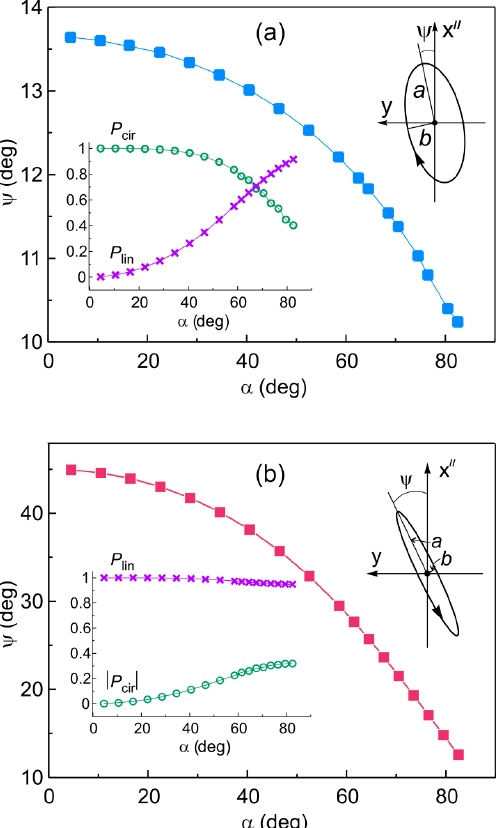
Figure 6. The angle ψ of the semi-major axis a of the refracted beam polarization ellipse relative to the plane of incidence σ , as well as the degrees of circular P cir and linear P lin polarizations of the refracted beam (insets) as a function of the angle of incidence α for ( a ) circularly and ( b ) linearly polarized ( Φ = − 45 ° ) radiation incident on a thin CuSe/ t -Se film (points are calculated values of ψ , P cir and P lin for angles α , for which photovoltage pulses were recorded, curves denote smoothing functions). The graphical insets show the corresponding calculated polarization ellipses of the re- fracted beam at α = 64.5 ° in the x ″ y coordinate system, where the x ″ axis lies in the refraction plane coinciding with the plane of incidence σ and is perpendicular to the wave vector of the refracted beam.